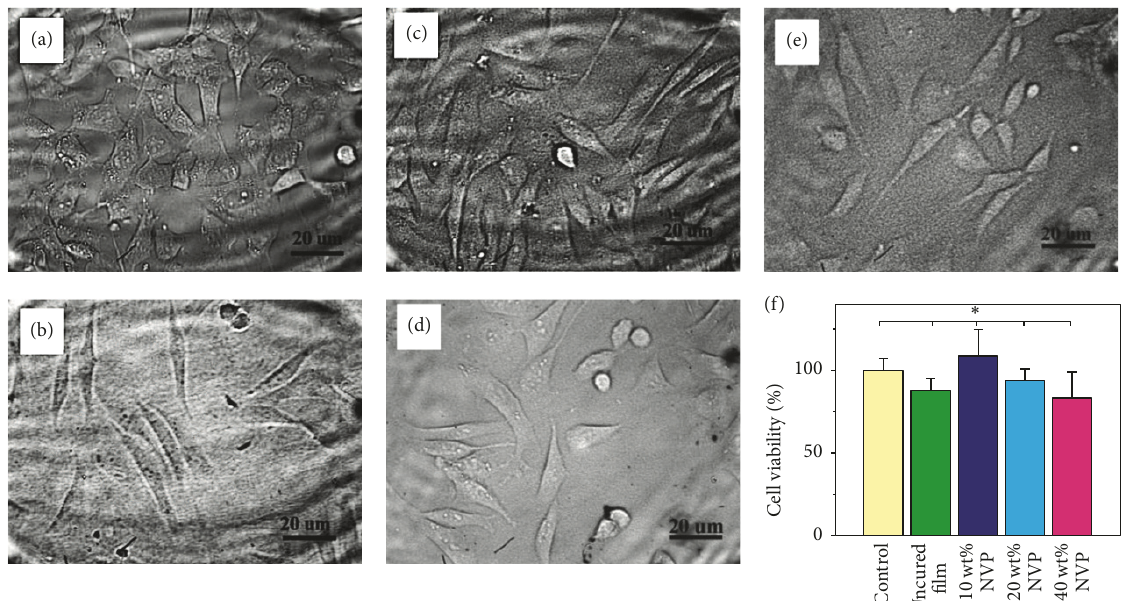
Figure 6: (a)–(d) Cell attachment of control, uncross-linked blend films of chitosan/pEGF (80/20) and cross-linked blend films of chitosan/pEGF (80/20) at 10wt%, 20wt%, and 40wt% of NVP cross-linker, respectively. Viability study of the mouse fibroblasts on the corresponding substrates [101] (figure obtained from an open access article distributed under the Creative Commons Attribution License). ∗ indicates statistically significant differences ( ∗ 𝑃 < 0.05